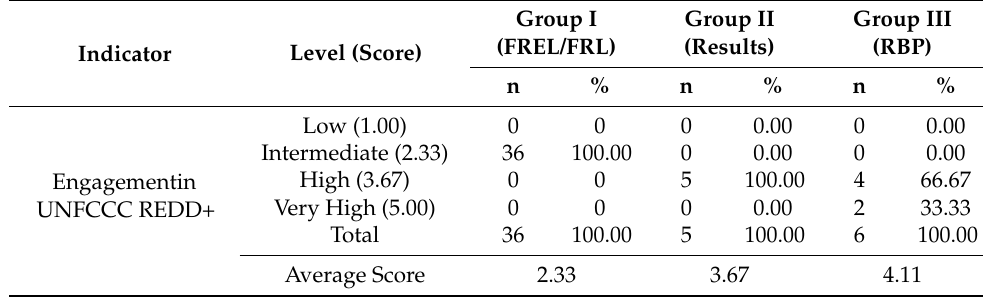
Table 4. Results of MRV capacity evaluation on national reports or submissions.